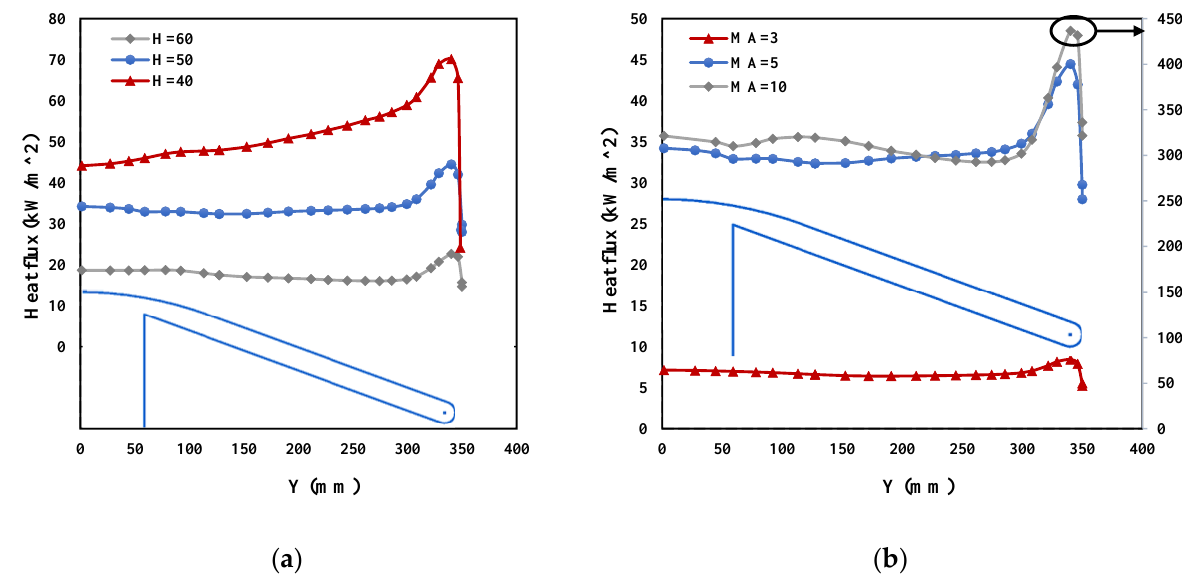
Figure 17. Heat flux distribution of case 0-0, case 7-1 to case 8-2: ( a ) H is changed; ( b ) Ma is changed.